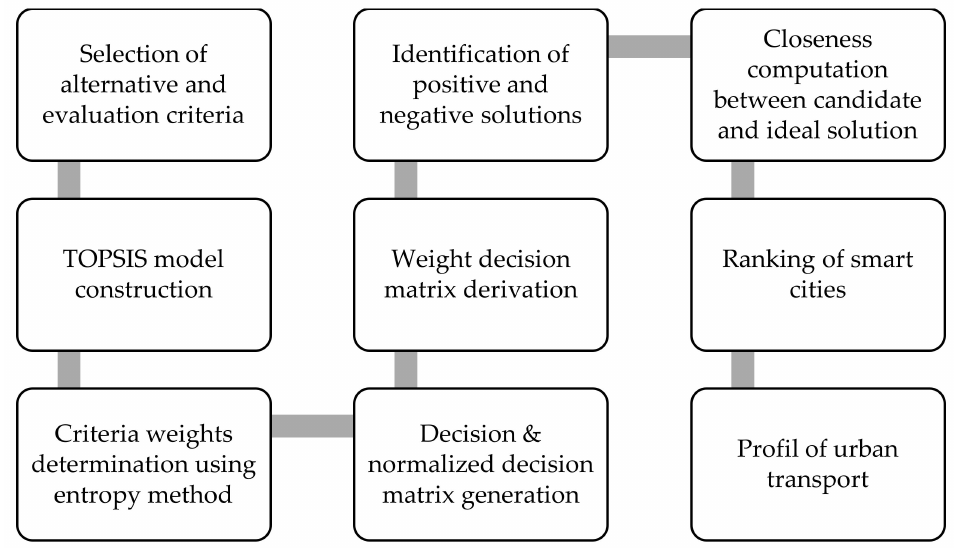
Figure 3. The research design. Source: author’s